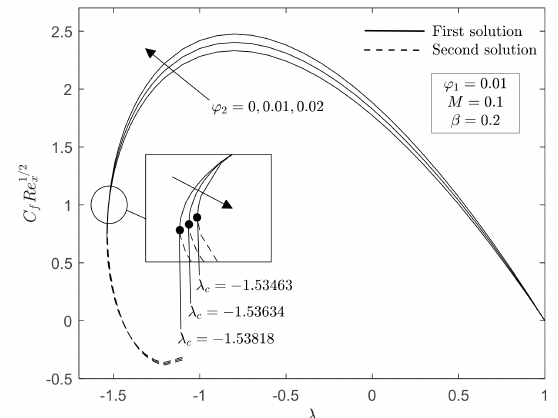
Figure 3. Temperature profile θ ( η ) for various values of ϕ 1 and ϕ 2 (Shrinking sheet case) when M = 0.1 and β = 0.2.